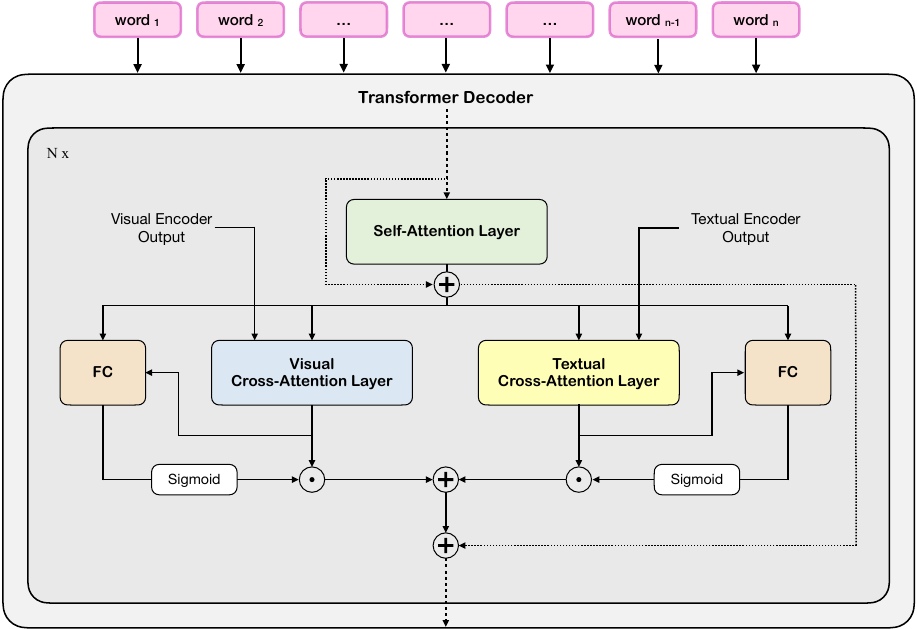
Figure 2. Architecture of the decoder, with attentive gates to integrate information coming from external